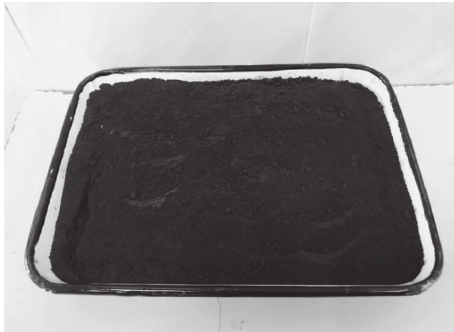
Figure 1: The RHA used in this study.